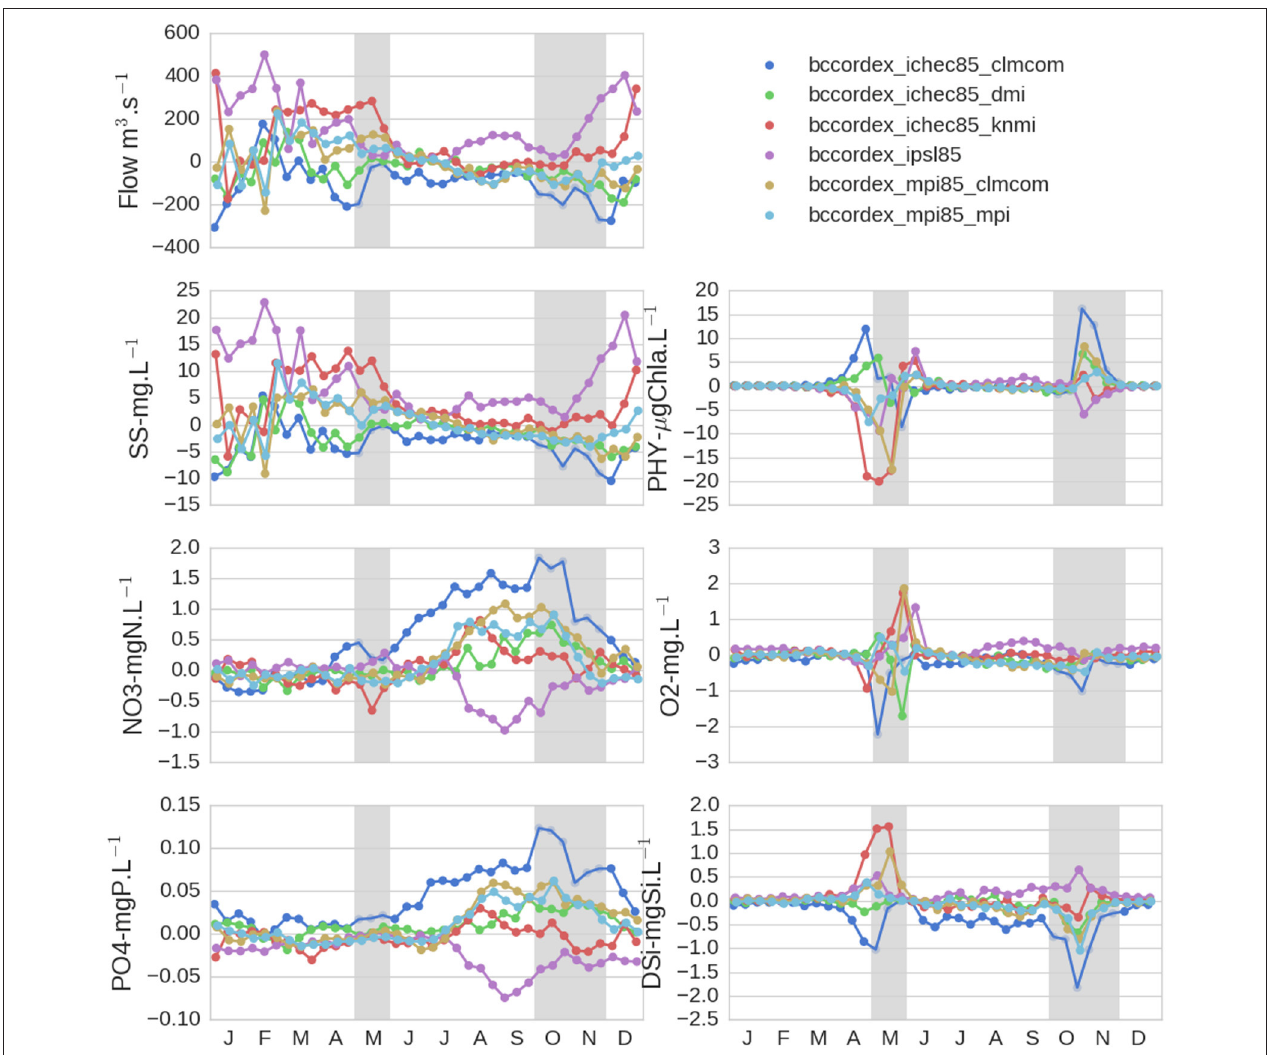
FIGURE 5 | Seasonal impacts of climate change on absolute changes in hydrological and biogeochemical variables at the outlet of the Seine River basin for the six projections of the RCP8.5 scenario. For each projection, absolute changes are the difference between 21-year averages for the 2080–2100 period and for the 1980–2000 reference period. The gray boxes represent periods where spatial impacts were studied in greater detail in Figures 6 , 7